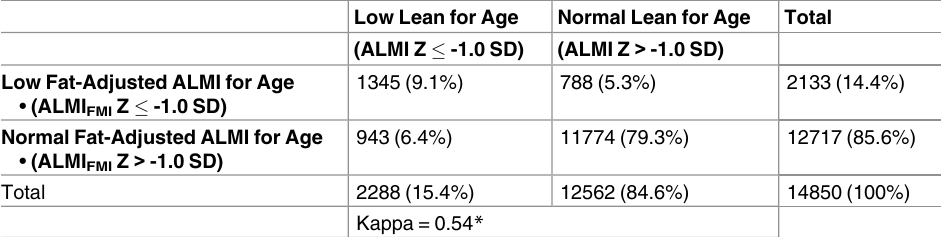
Table 3. Assessment of the correlation between standard and fat-adjusted measuresof low lean mass for age (as defined as an ALMI greater than 1 SD below the mean). Low Lean for Age Normal Lean for Age Total (ALMI Z (cid:20) -1.0 SD) (ALMI Z > -1.0